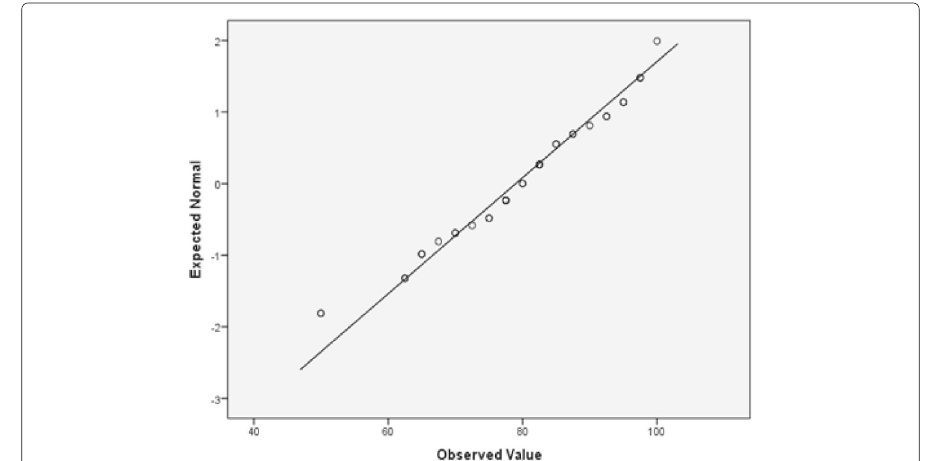
Fig. 36 Normal Q-Q Plot of the SUS scores of the BOS